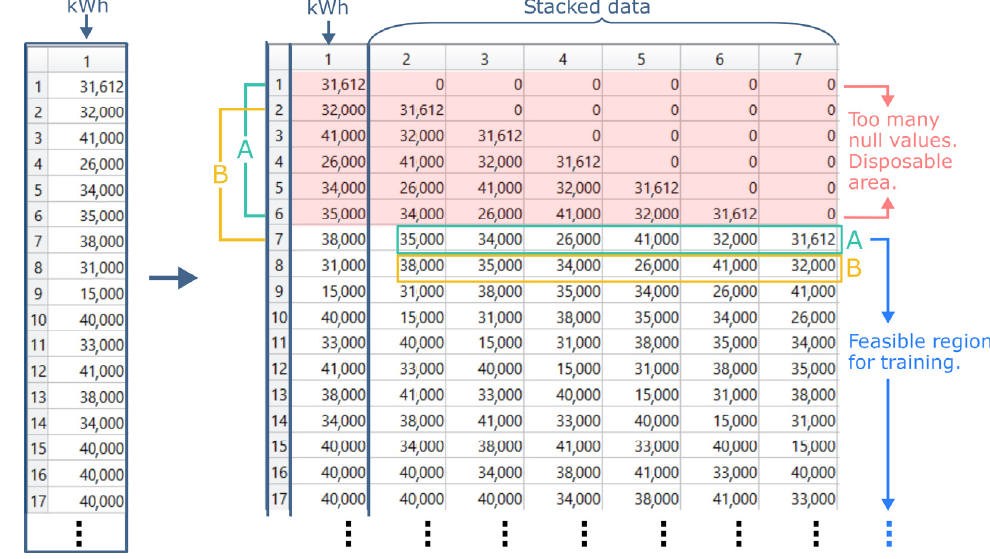
Figure 5. Reorganizing generation data for training: stacking data for training based on information from the previous 6 days. Source: own authors.